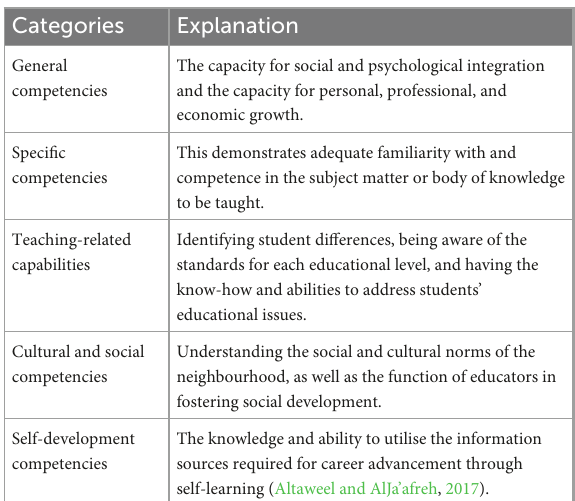
TABLE 1 The five categories of educational